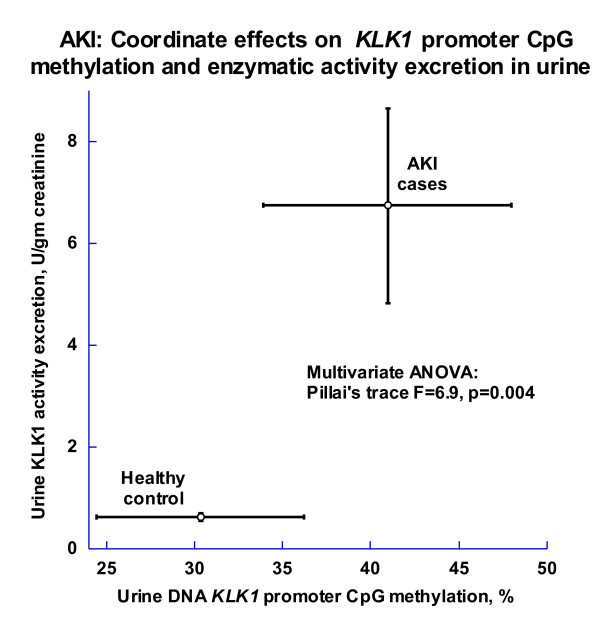
AKI: Coordinate effects of disease on KLK1 promoter CpG methylation and KLK1 enzymatic activity excretion in urine. The multivariate analysis compared established AKI cases with healthy controls.